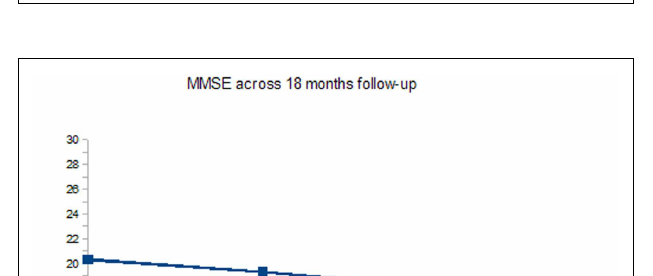
FIGURE 2 |ANOVA results for NPI score .